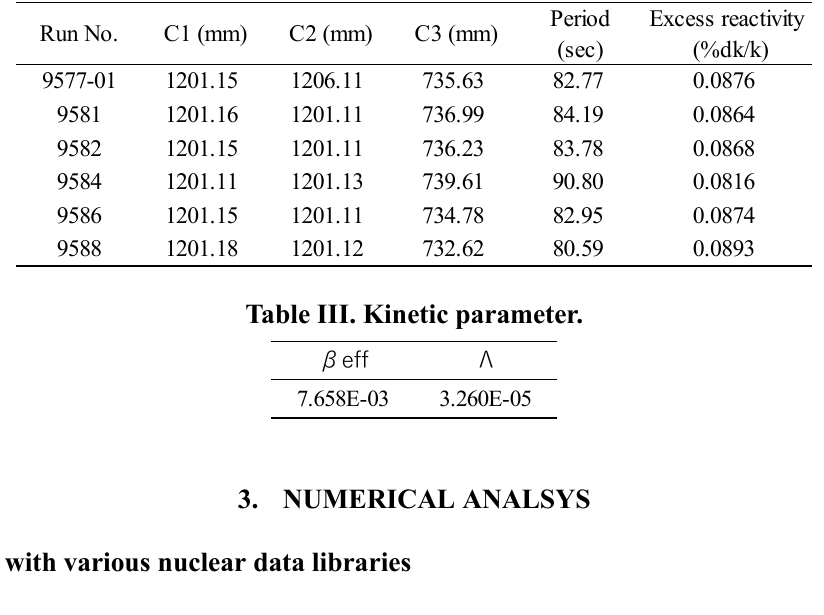
Table II. Measured excess reactivity.